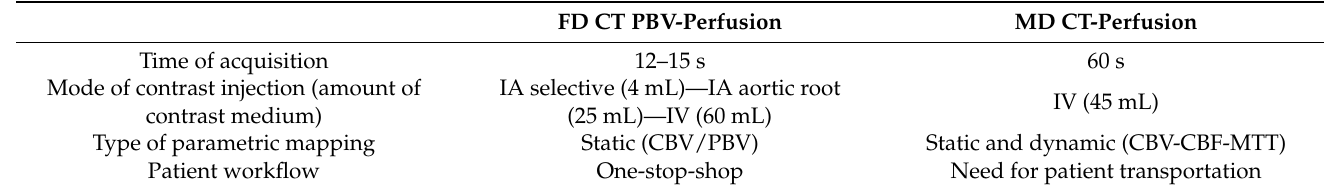
Table 1. Comparison of FD CT PBV perfusion imaging with MD CT perfusion imaging. Approxi- mative values of different aspects of the two imaging modalities are presented. IV = intravenous, IA =